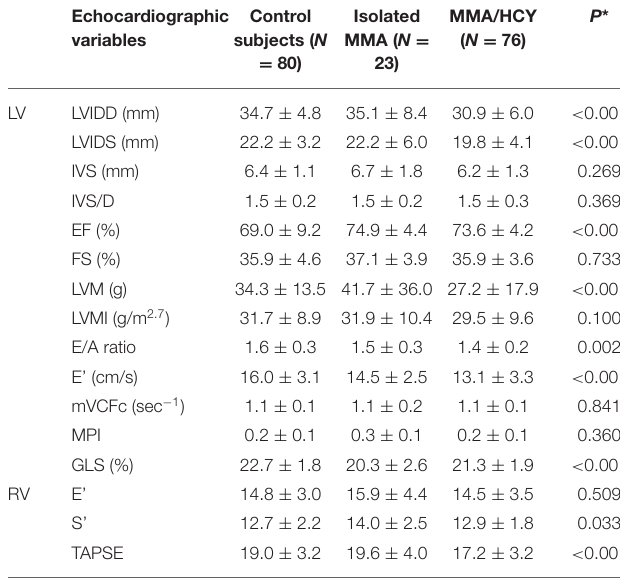
TABLE 2 | Echocardiographic parameters of isolated MMA and MMA/HCY groups. Parameters